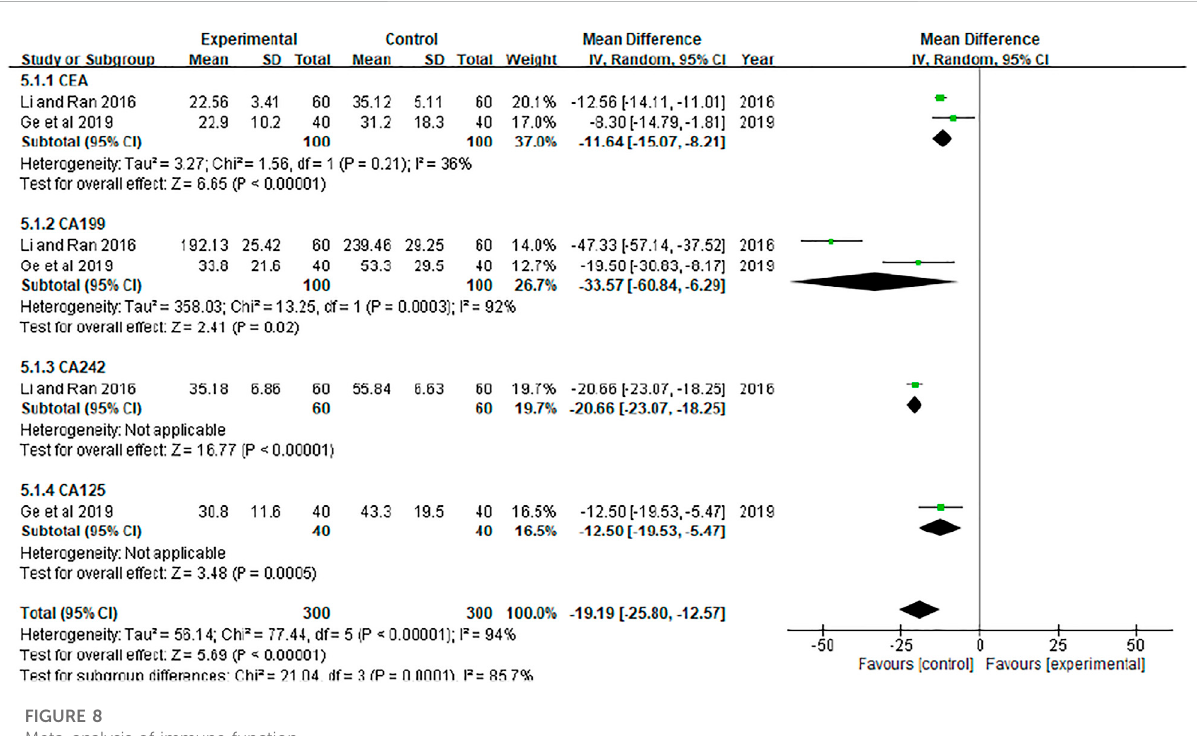
FIGURE 8 Meta-analysis of immune